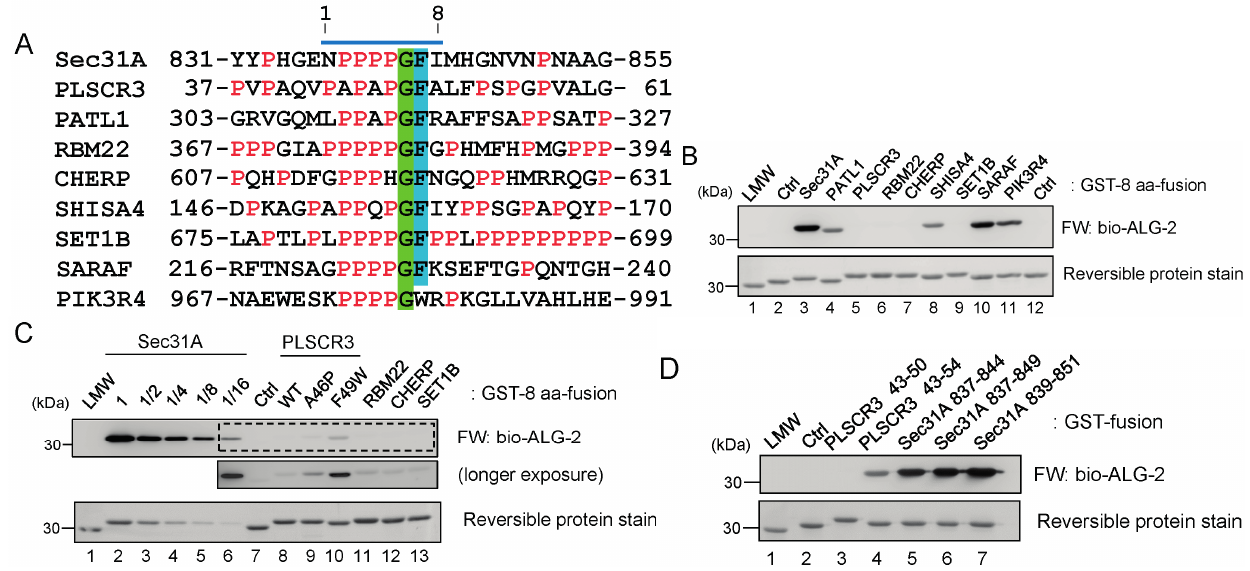
Figure 9. Comparison of ALG-2-binding motif type 2 sequences. ( A ) Amino acid sequences of known and potential ALG-2-binding proteins. The sequence of the ALG-2-binding site in Sec31A is compared with similar sequences from other known ALG-2-binding proteins (PLSCR3, PATL1, RBM22, CHERP) or with those from proteins whose interactions with ALG-2 have not yet been determined (SET1B, SARAF, PIK3R4) or need to be confirmed (SHISA4). Prolines are highlighted in red. Conserved glycines and phenylalanines are highlighted in light-green and cyan, respectively. A bar above the Sec31A sequence indicates an 8-aa segment used for the preparation of GST-fused peptides shown in ( B ) (GST-8 aa-fusion); ( B ) FW analysis. ALG-2-binding activities of GST-8 aa-fusion proteins were determined by FW with bio-ALG-2. Lane 1, low molecular weight (LMW) marker proteins; Lanes 2 and 12, control GST (Ctrl); Lanes 3–11, GST-fused peptides containing 8-aa sequences shown in ( A ). Top , FW, exposure time of 10 s; bottom , reversible protein stain; ( C ) FW analysis of weak binding proteins. The GST 8-aa fusion protein of Sec31A was serially diluted to decrease the FW signal intensity. An image of longer exposure time (130 s) of chemiluminescence reaction is presented to show positive signals for other proteins in the area surrounded by the broken line in the top panel (longer exposure); ( D ) The ALG-2-binding activities of longer PLSCR3 and Sec31A peptides. ALG-2-binding activities of GST-fusion proteins of longer peptides of PLSCR3 (Lane 3, 8 aa, encoding 43–50; Lane 4, 12 aa, encoding 43–54) and Sec31A (Lane 5, 8 aa, encoding 837–844; Lane 6, 13 aa, encoding 837–849; Lane 7, 13 aa, encoding 839–851) were analyzed by FW with bio-ALG-2. Lane 1, low molecular weight (LMW) marker proteins; Lane 2, negative